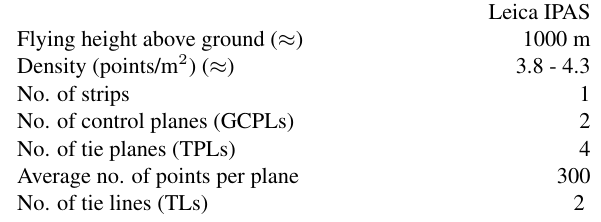
Table 4: Castellbisbal block geometric configuration.